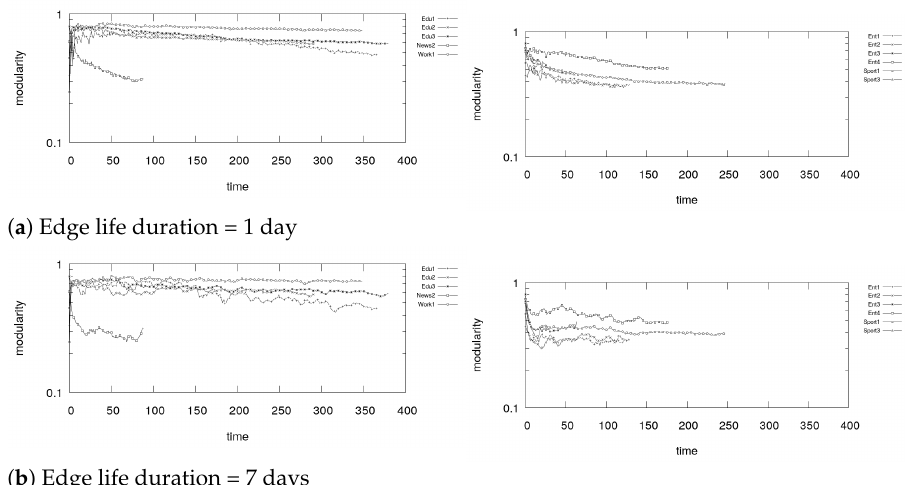
Figure 23. Modularity of communities detected by Fast